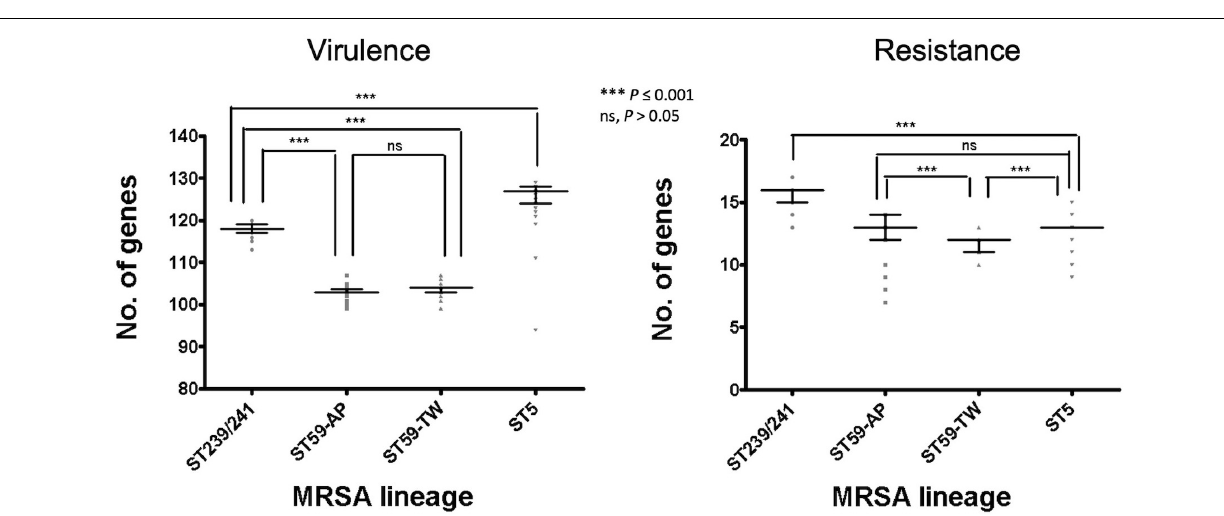
FIGURE 6 | Comparison of the numbers of carried virulence and resistance genes among methicillin-resistant Staphylococcus aureus of different genetic lineages, including the Taiwan clone and the Asia-Pacific clone of ST59. The comparisons were conducted with one-way ANOVA method with Tukey’s multiple-comparison